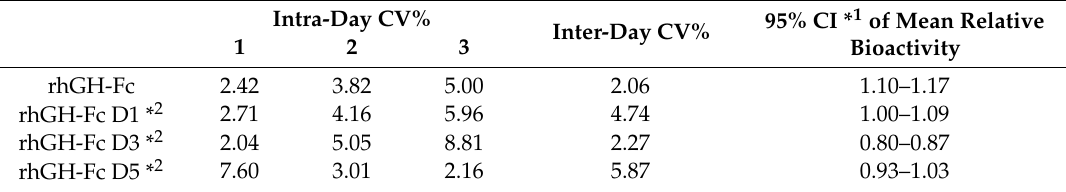
Table 1. The precision of the rhGH-Fc bioactivity results.